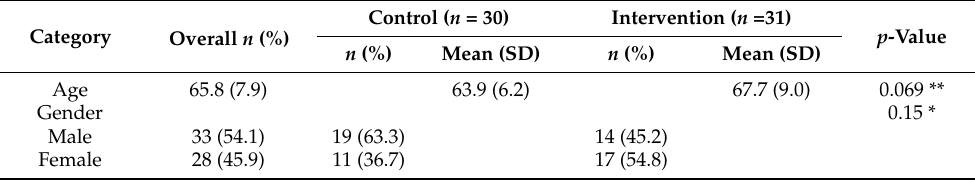
Table 1. Comparison of baseline socio-demographic variables between groups.